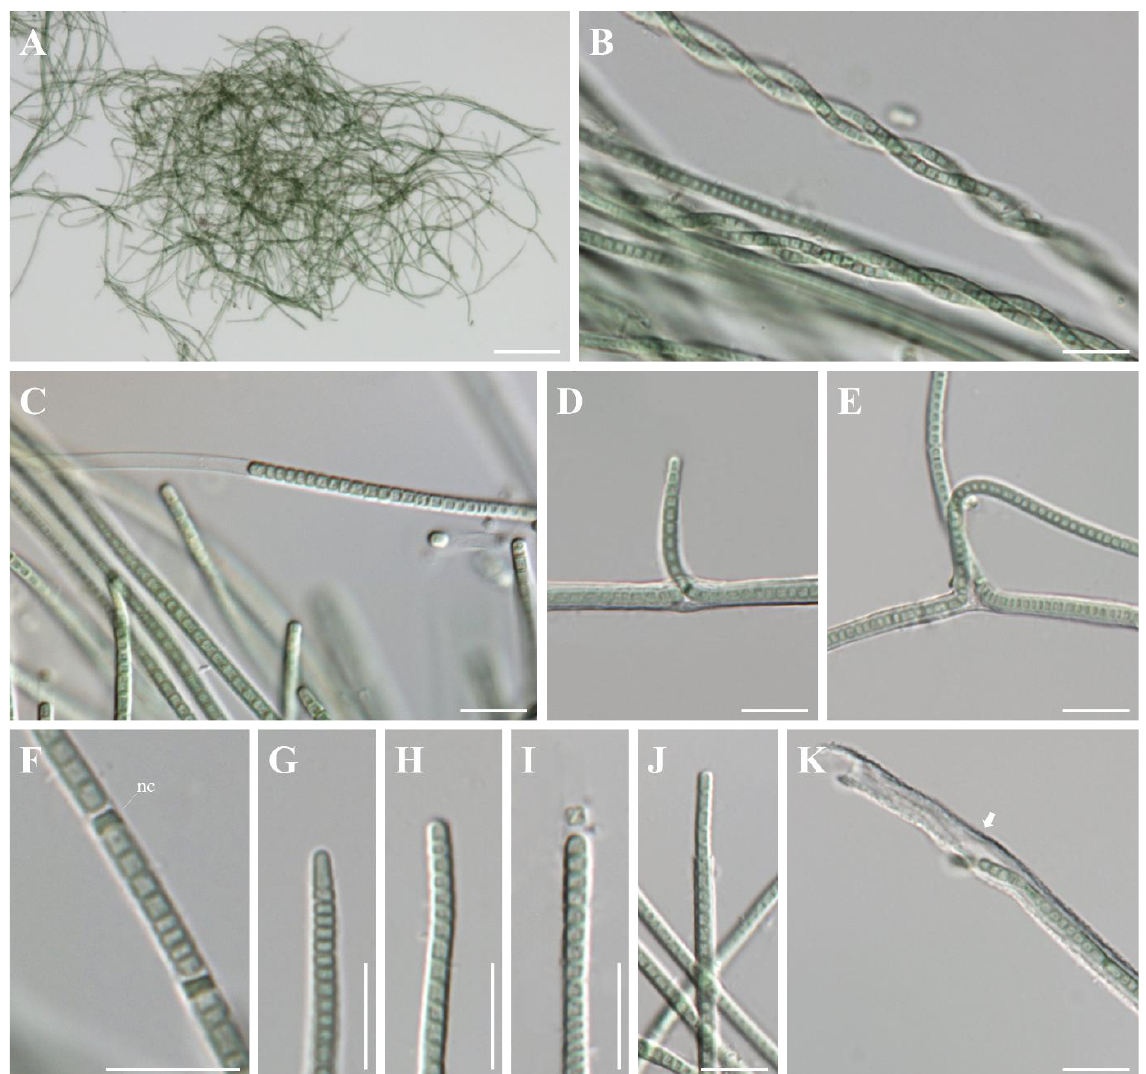
Figure 6. Microphotographs of Plectolyngbya salina from the strain FBCC-A1477. ( A ) Colonies (mats) formed in culture, ( B ) Trichomes twisted into a rope, ( C ) Details of trichomes, ( D ) Tolypothrix -type of false branching, ( E ) Scytonema -type of false branching, ( F ) Trichome with necridic cell (nc), ( G – I ) Morphologies of apical cells, ( J ) Trichome coming out of the sheath, ( K ) Trichome with slightly widened sheath (arrow) after 4 weeks of culture. Scale bars ( A ) 100 µ m, ( B – K ) 10 µ m. Description: Filament solitary or in a small colony, straight or waved and sometimes gently twisted. Trichomes blue-green, not attenuated towards the ends. Cells cylindrical or slightly barrel-shaped, 1.0–2.5 µ m long and 1.5–2.0 µ m wide, longer or shorter than wide, clearly constricted at the cross-walls. Sheaths very thin, colorless, attached or slightly widened from the trichomes, diffluent. Apical cell conical or rounded without calyptra. False branching obligatory, branches solitary or in pairs. Reproduction hormogonia with necridic cells. Thylakoids parietal or